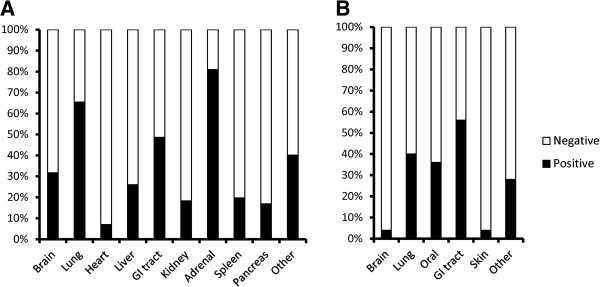
Distribution of cytomegalovirus and Candida albicans. (A) CMV positive rate in each organ. Black bar indicates the CMV positive rate in each organ from 142 CMV-positive patients. Because CMV was detected in more than one organ per patient, the sum of the black bars is over 100%. (B) The positive rate of Candida albicans in each organ. Black bar indicates the positive rate of Candida albicans per organ from 25 Candida albicans-positive patients.